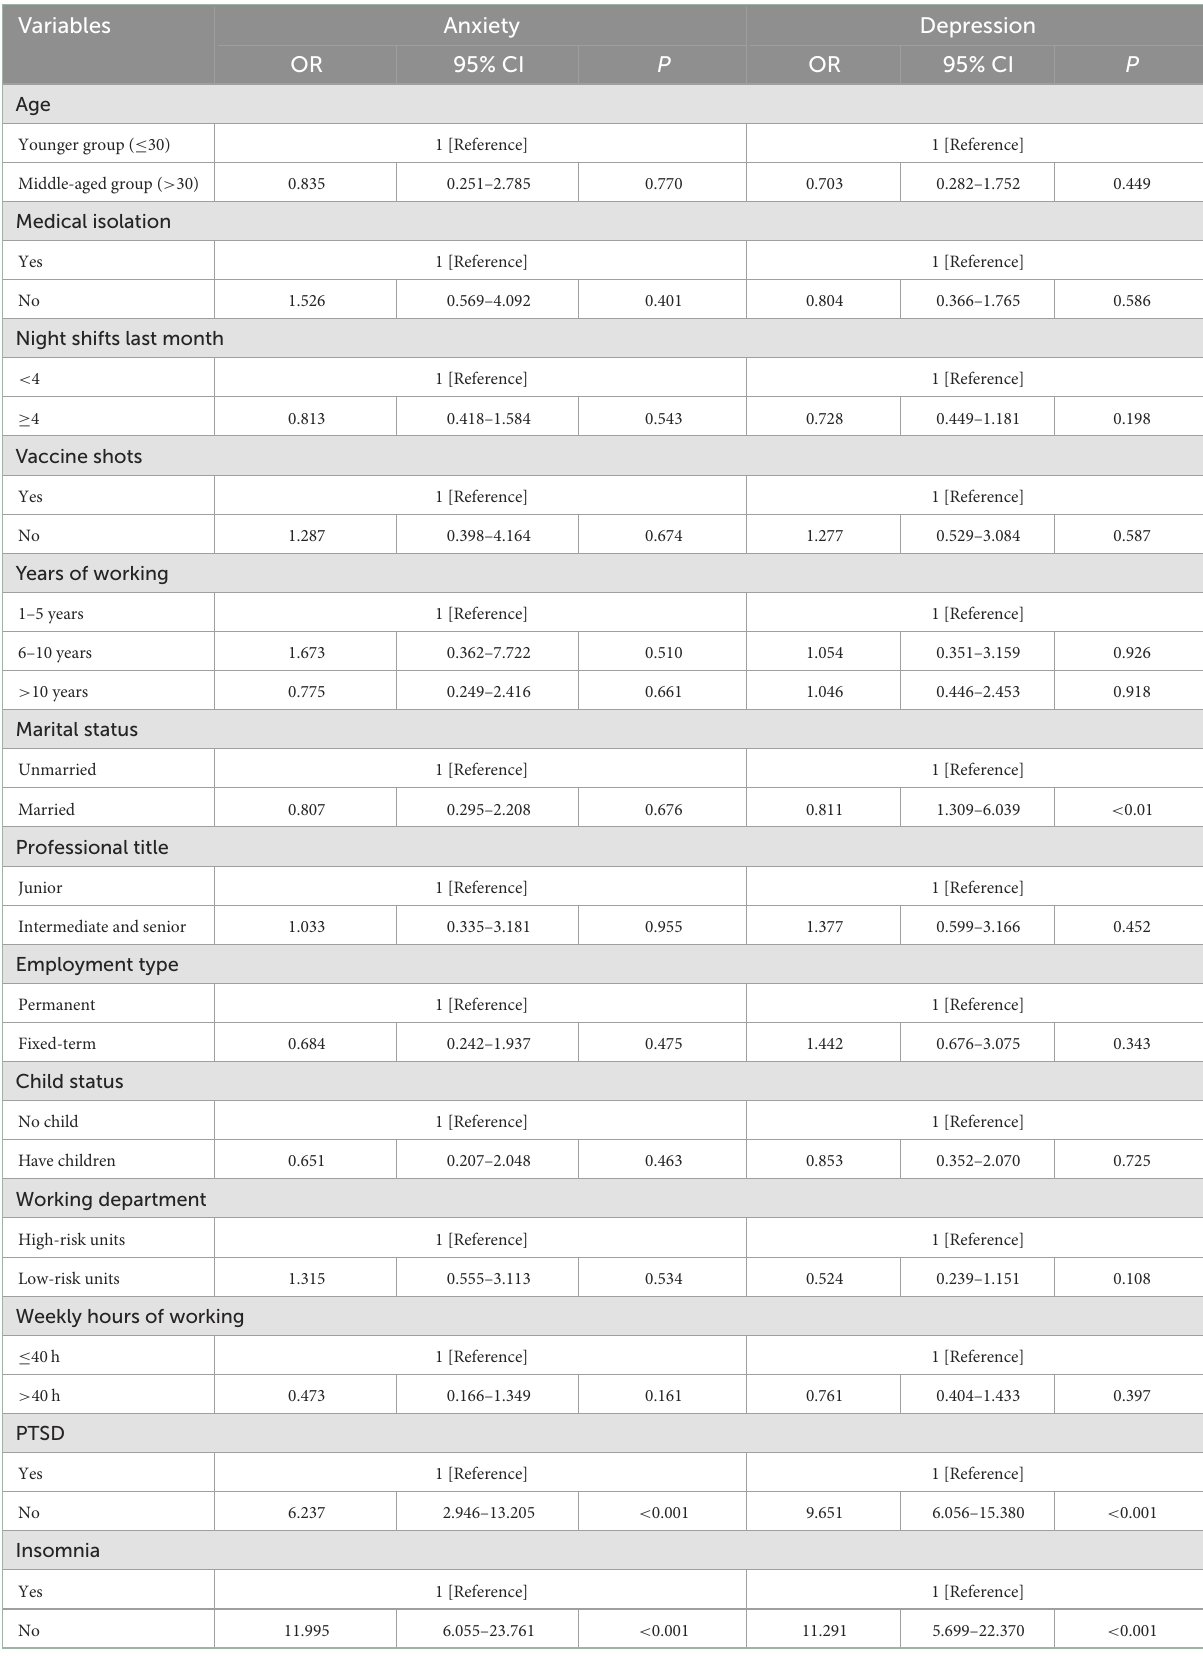
TABLE 2 Associated factors of mental health status identified by binary logistic regression